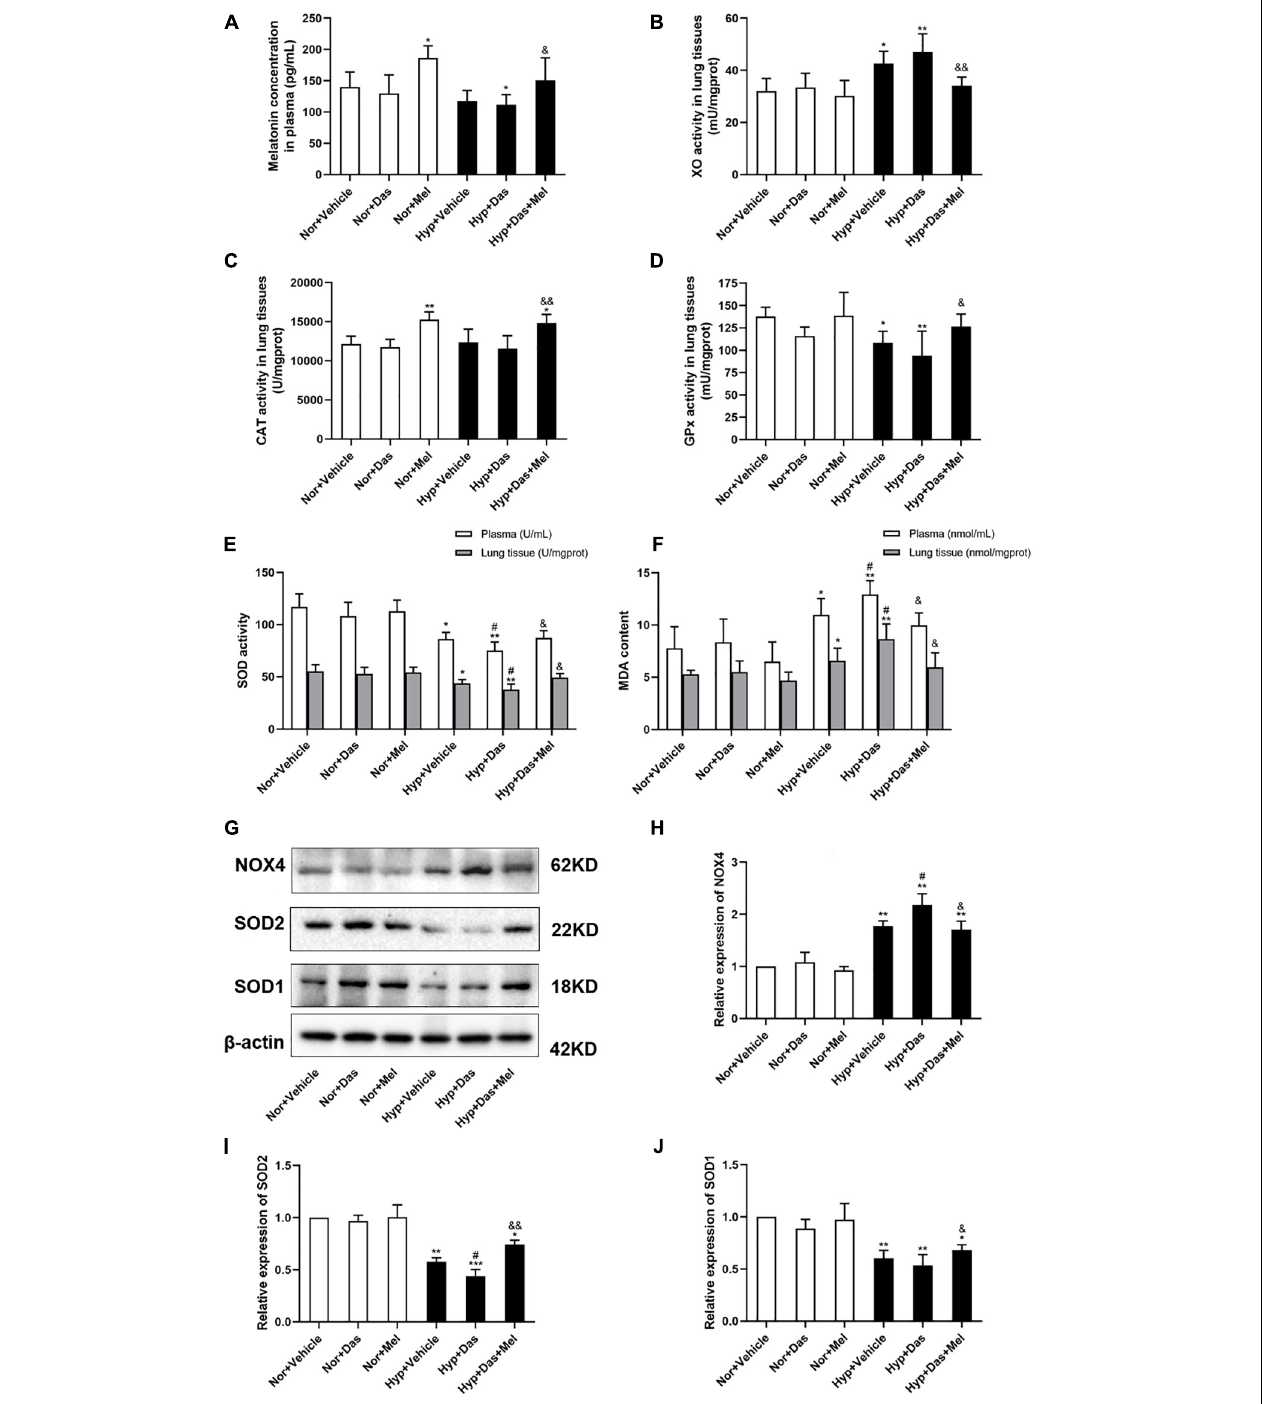
FIGURE 5 | Melatonin attenuates pulmonary oxidative stress induced by dasatinib under hypoxia. The melatonin concentration in rat plasma (A) , xanthine oxidase (XO) activity in rat lung tissues (B) , Catalase (CAT) activity in rat lung tissues (C) , Glutathione peroxidase (GPx) activity in rat lung tissues (D) (n = 6). The activity of superoxide dismutase (SOD) in rat plasma and lung tissues (E) , Malondialdehyde (MDA) content in plasma and rat lung tissues (F) ( n = 6). Protein expression of NOX4, SOD2, and SOD1 in rat lung tissues (G) . Bar graph shows the statistic results of NOX4 (H) , SOD2 (I) , and SOD1 (J) protein levels ( n = 3). Values are means ± SEM, ***P < 0.001, **P < 0.01, *P < 0.05 compared with Nor + Vehicle group. # P < 0.05 compared with Hyp + Vehicle group. && P < 0.01, & P < 0.05 compared with Hyp + Das group.